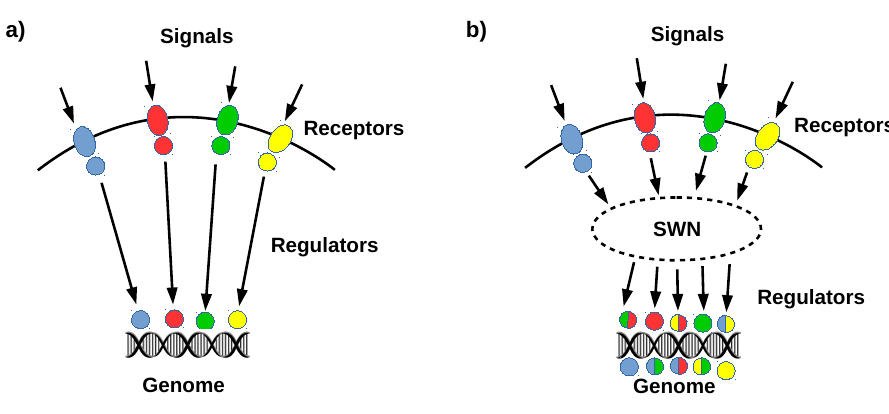
Figure 4. Simplified cartoon of sensing and regulation systems in ( a ) prokaryotes (archaea and bacteria) and ( b ) eukaryotes. Regulatory signals can interact and cross-modulate in eukaryotes more than in prokaryotes. Colors indicate communicated information. SWN = small-world network